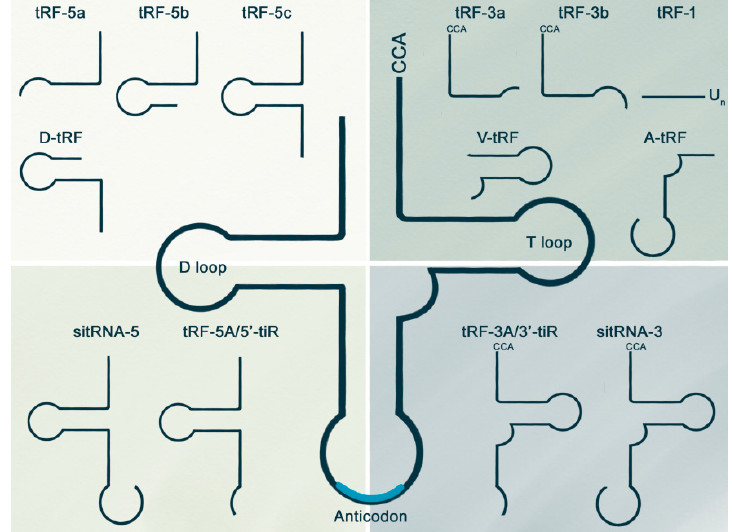
Figure 2. Several types of tRFs are classified by size and sequence location in the tRNA structure. tRFs are generated during pre-tRNA processing or from mature tRNAs. tRF-1 is generated by RNaseZ, which cleaves 3 ′ trailer sequences from pre-tRNA. Half-sized tRFs are grouped by whether their source sequences are from 5 ′ or 3 ′ fragments. Longer tRFs than tRNA halves are termed sitRNAs. In the case of short-length tRFs, subtypes are determined by size and location of the source. See the